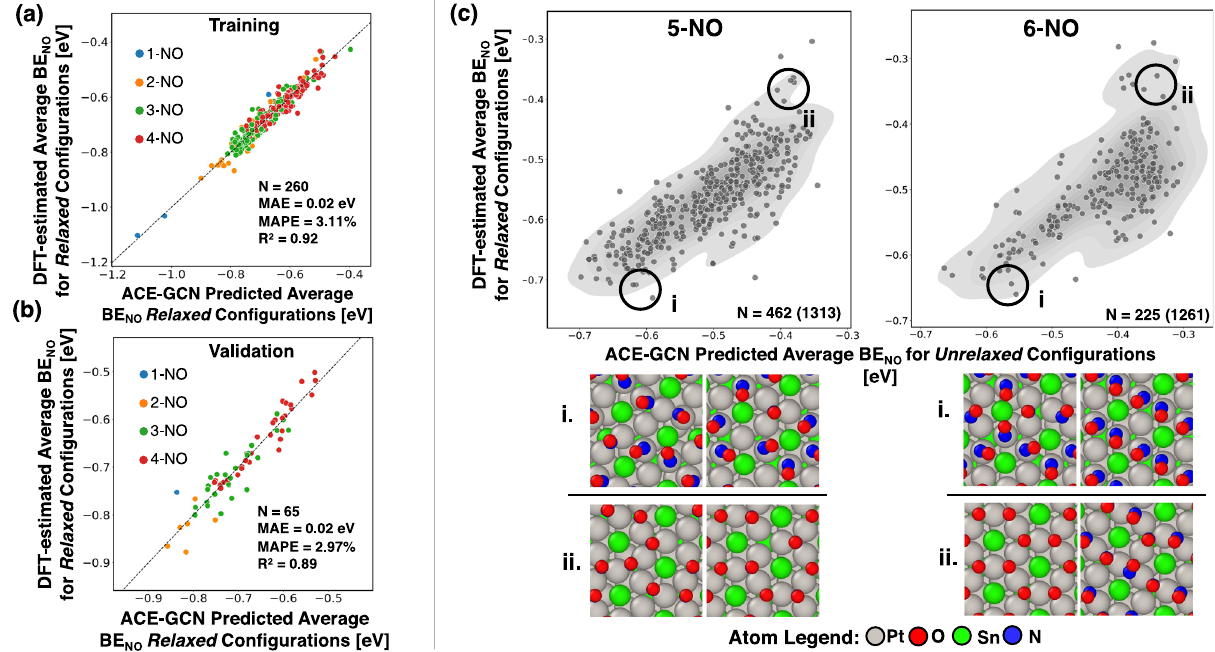
Fig. 3 | Screening high coverage NO* con fi gurations on Pt 3 Sn(111). Con fi gura- tional analysis of NO* adsorption on Pt 3 Sn(111), where ACE-GCN is used to predict energetics of the unrelaxed con fi gurations generated using SurfGraph. ( a ) and ( b ) correspond to training and validation parity plots foranACE-GCN model with NO* con fi gurations consisting of1 – 4 NO* molecules per unit cell.Test set performance and training related to con fi gurations with 4 NO* molecules per unit cell are dis- cussed inthe Supplementary Information, Fig. S8. ( c ) gives predictions of the ACE- GCN model, trained on con fi gurations of 1 – 4 NO* molecules per unit cell, for sta- bility of unrelaxed 5 and 6 NO* con fi gurations generated with SurfGraph. The